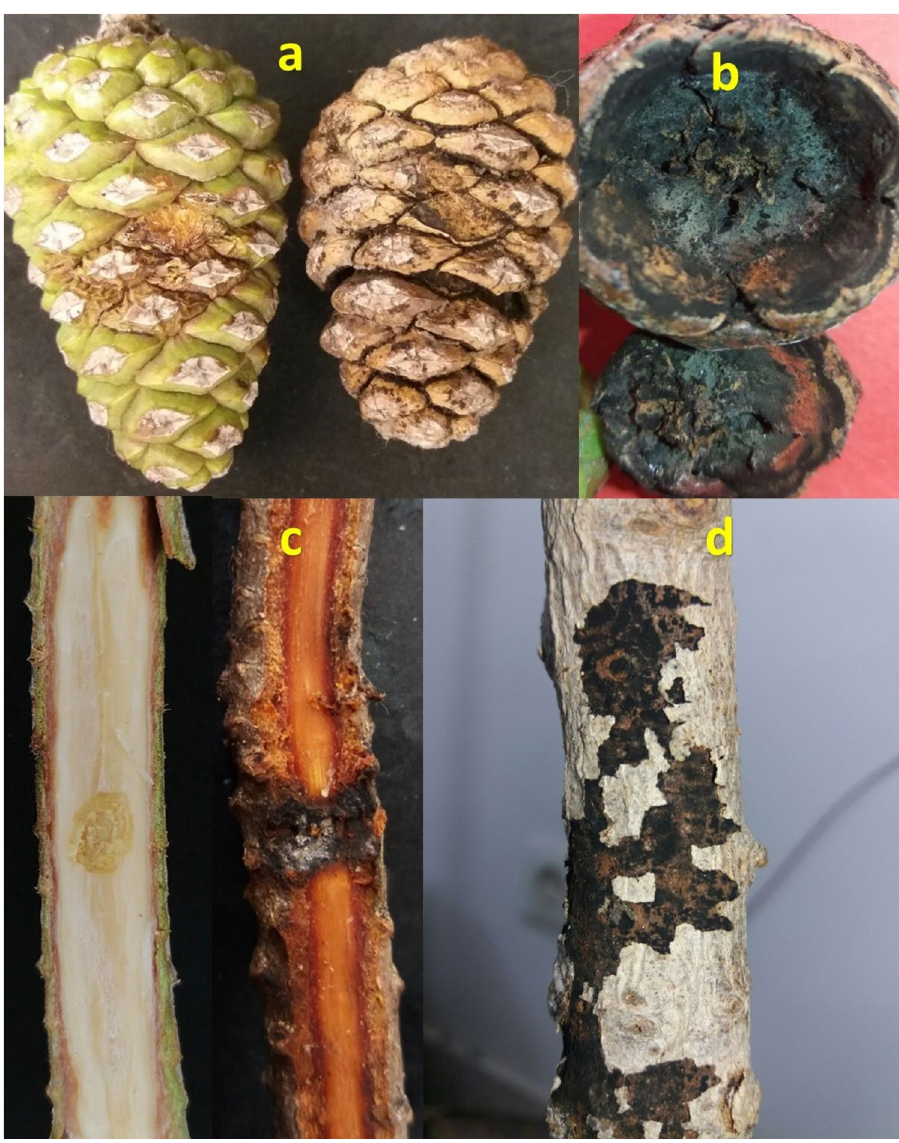
Figure 6. Pathogenicity tests. Negative control after inoculation with PDA ( a -left); symptom on the fruit of pine after inoculation with the fungal disc ( a -right); black spores of Neoscytalidium novaehollandiae with fruit separation of each other after 20 days ( b ); negative control ( c -left); symptom on detached branches after 40 days ( c -right); five-year-old trees treated with N. dimiditum black spores after 60 days ( d ). After annihilating the host tree, the fungi produced an asexual stage and tore the bark to